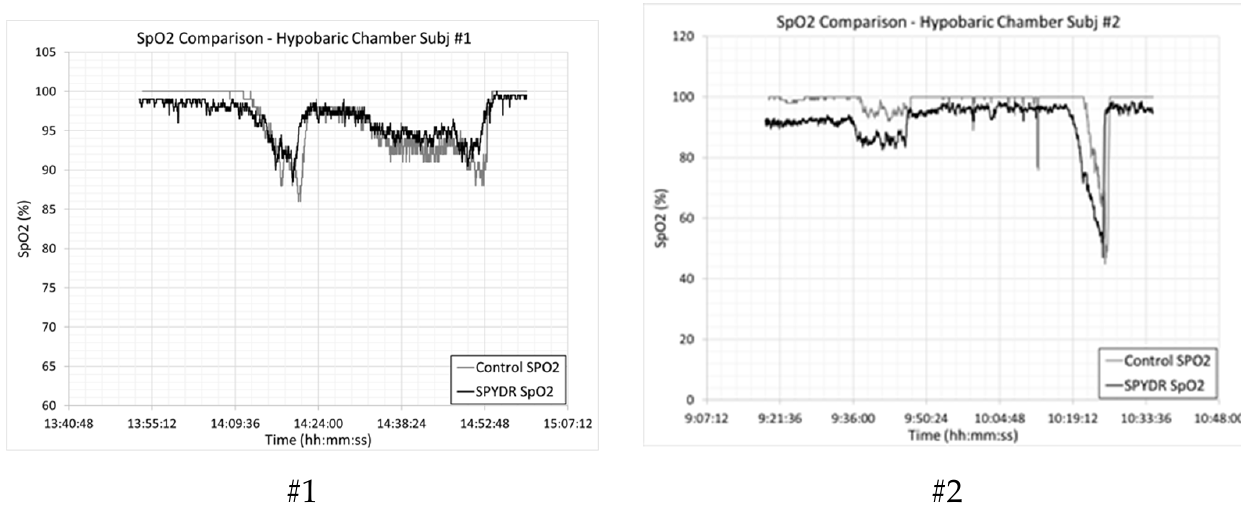
Figure 2. Comparison of blood oxygen saturation (SpO2) as measured by SPYDR vs. control finger PPG sensor. Note that SPYDR responds to changing physiological conditions faster than the peripheral finger sensor, especially noticeable during a period of acute hypoxia of Subject #2 in the right panel, supporting findings from a previous study. Correlation by Pearson was 0.92 for test #1 and 0.89 for test #2.